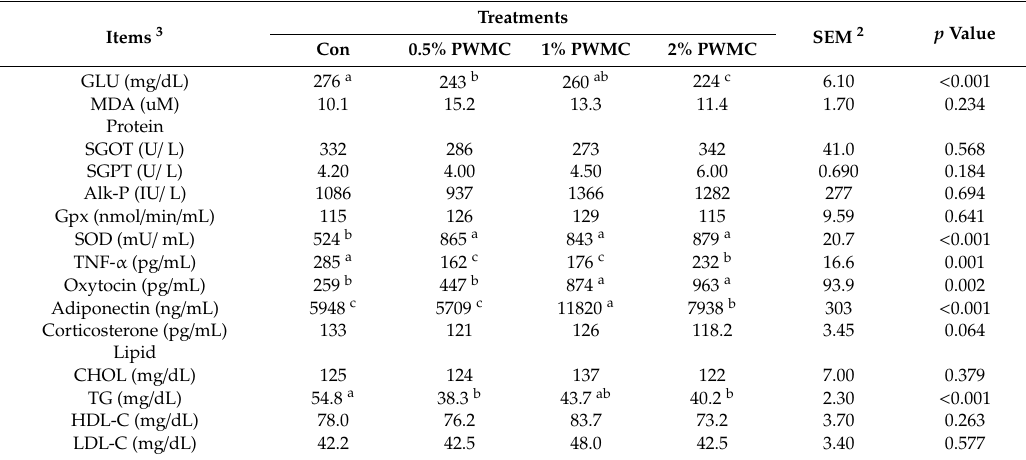
Table 6. Serum characteristics of 35-day-old broilers following PWMC 1 supplementation.